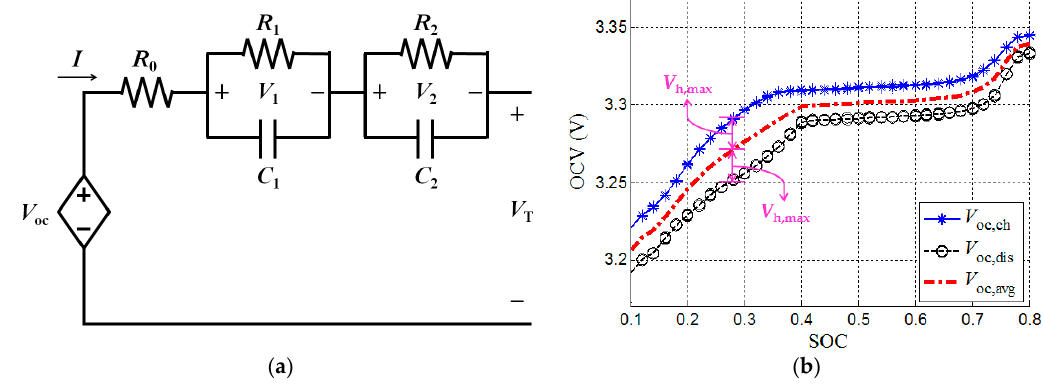
Figure 1. ( a ) The Overall Scheme of equivalent circuit model (ECM) and ( b ) open circuit voltage (OCV), versus state of charge (SOC).